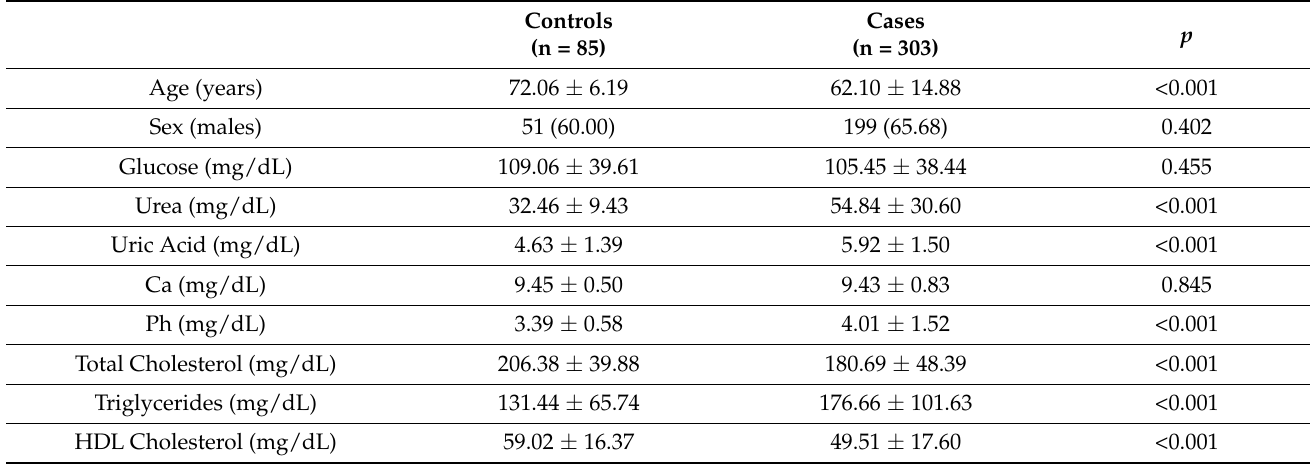
Table 1. Clinical characteristics of cases and control